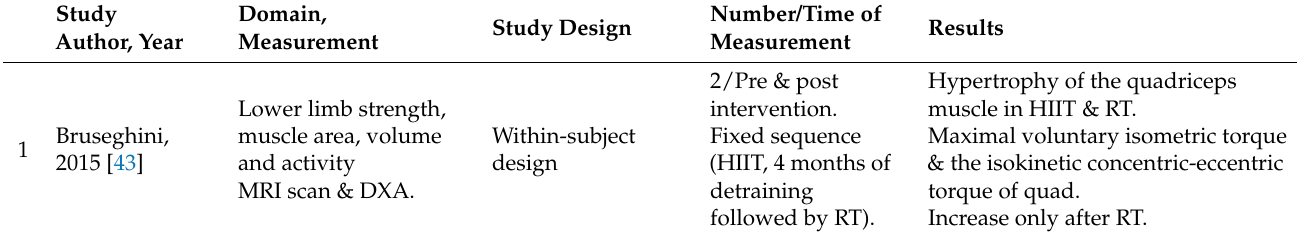
Table 5. Summary of outcome measures, study design, measurement, and